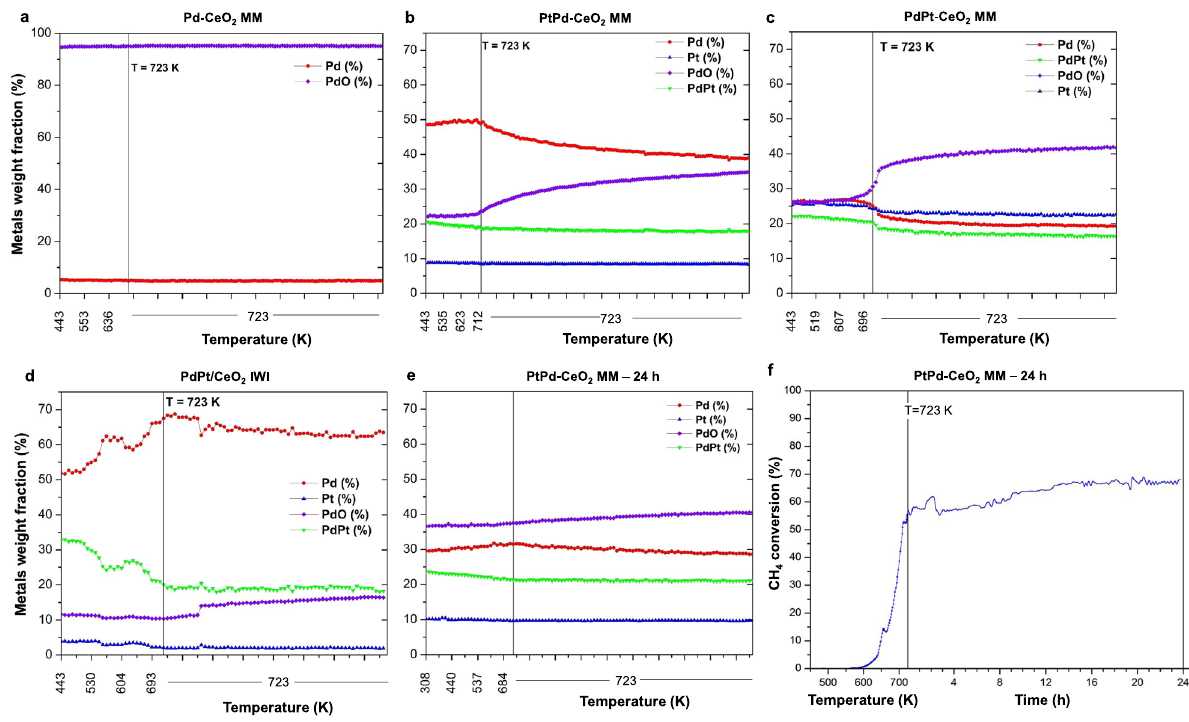
Fig.2|Evolutionofthenormalizedweightfractionofthephasesobtainedfrom the Rietveld re fi nement under wet lean methane oxidation conditions at dif- ferent temperatures. a – e For the indicated catalysts. f Methane conversion of